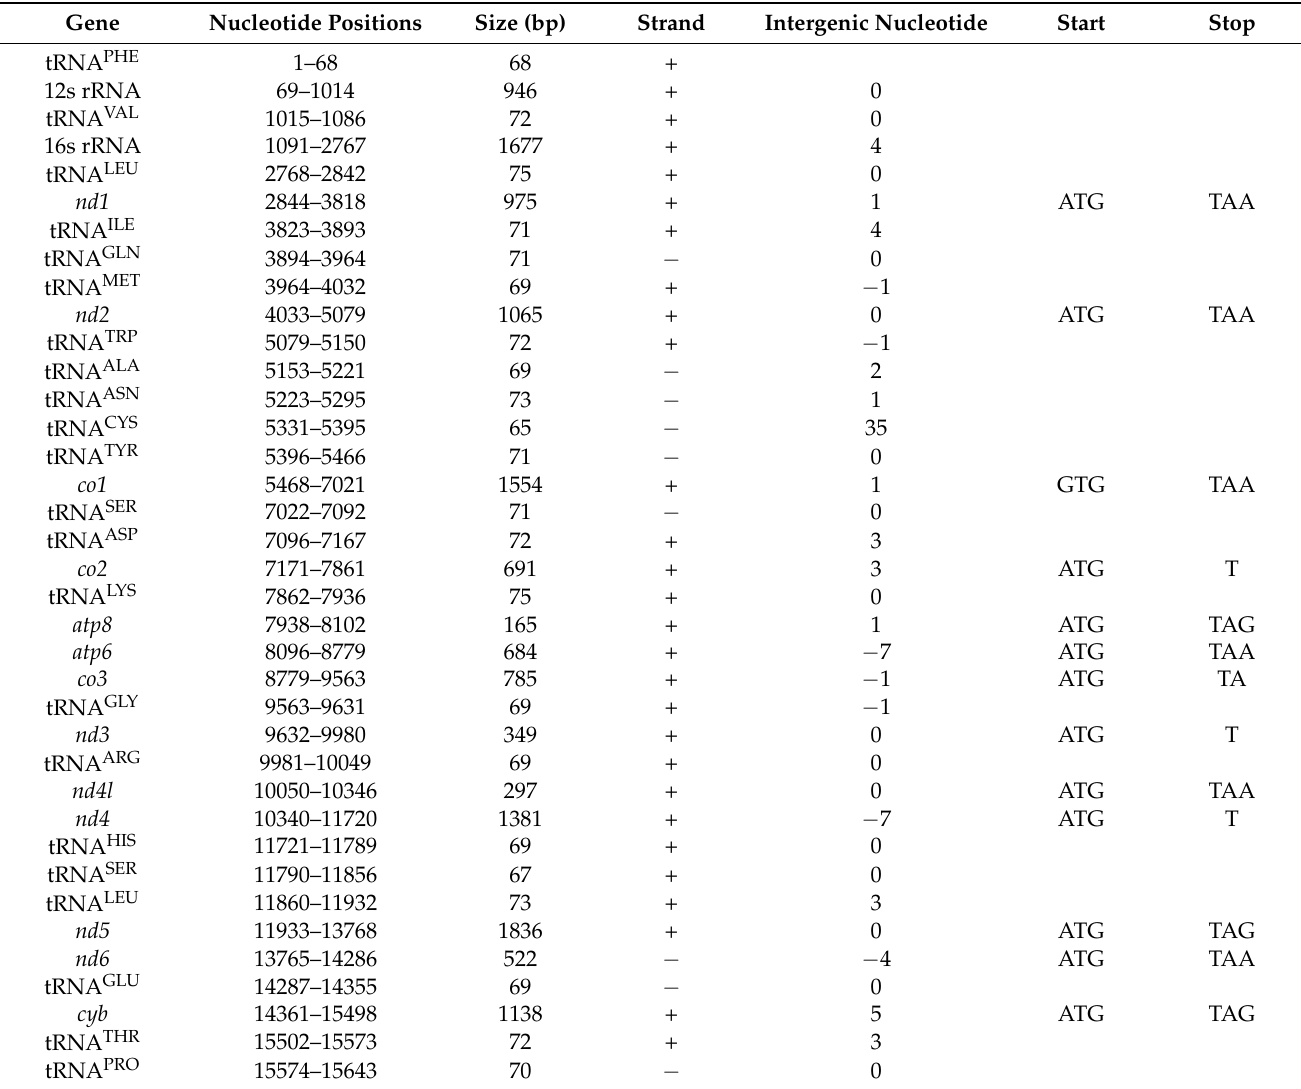
Table 2. Characteristics of the mitochondrial genome of Chaenogobius annularis .